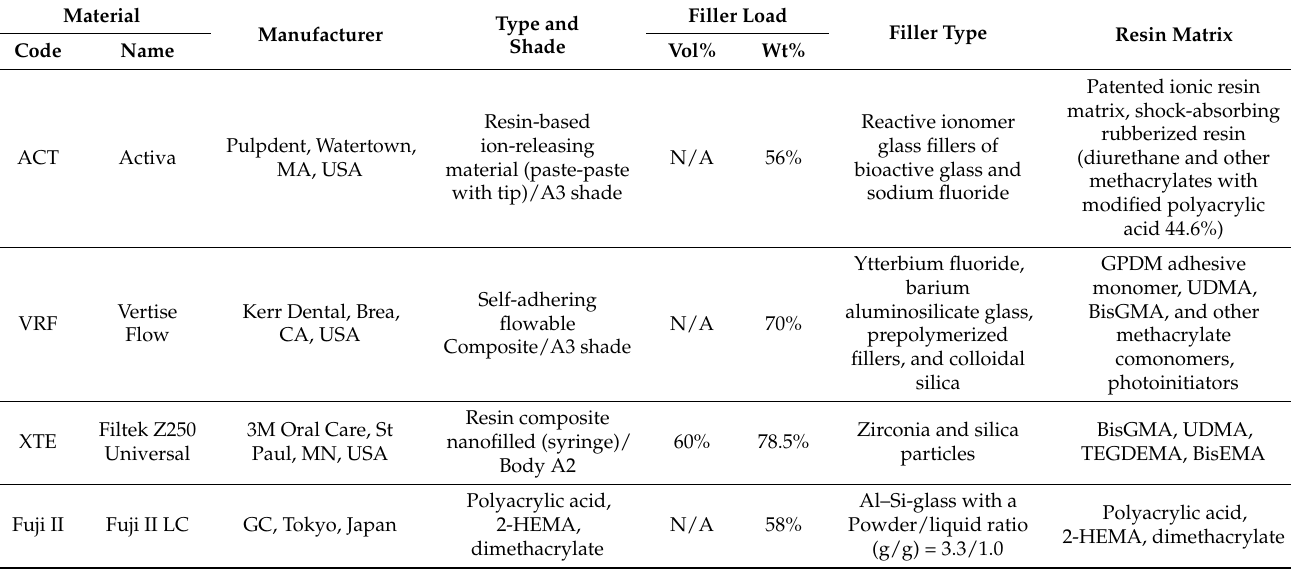
Table 1. Materials tested and their